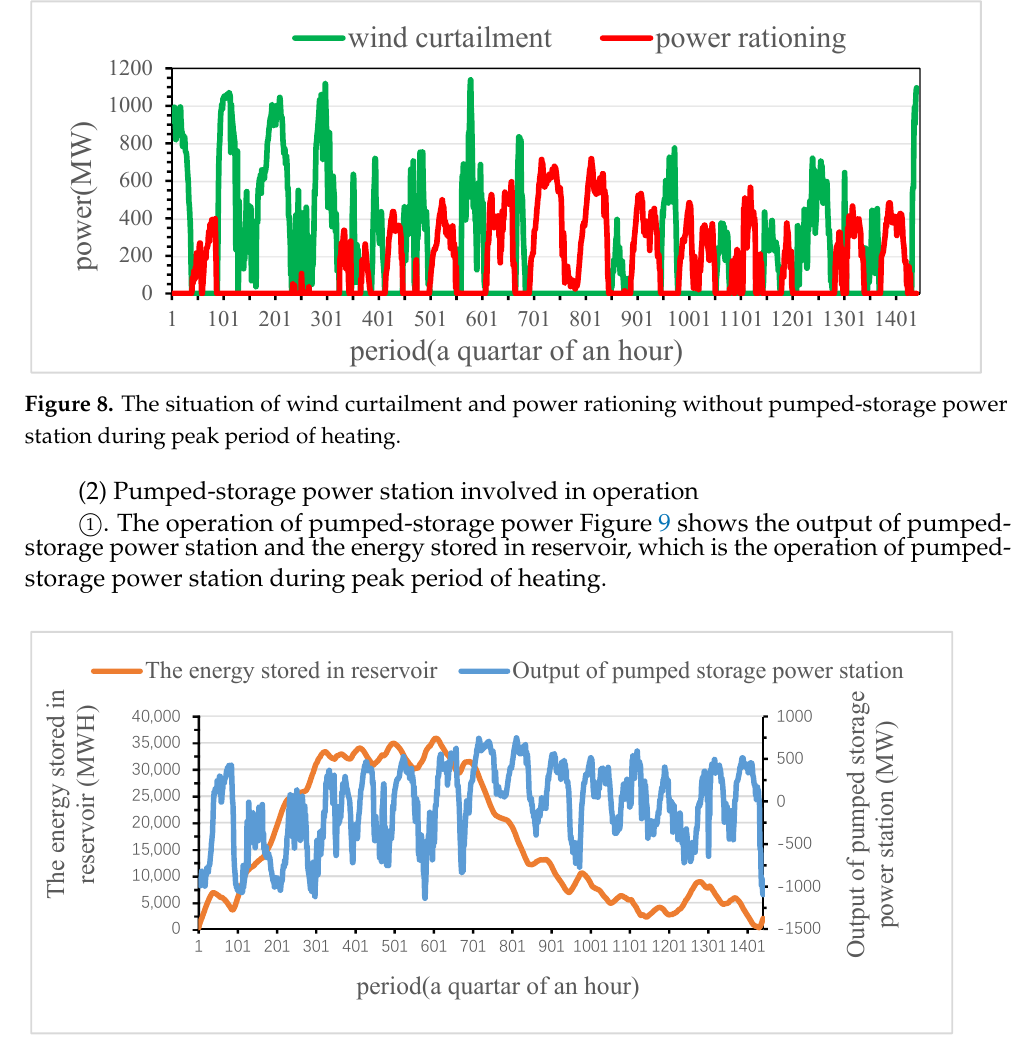
Figure 9. Operation of pumped-storage power station in heating peak period. 2 (cid:13) . The load composition